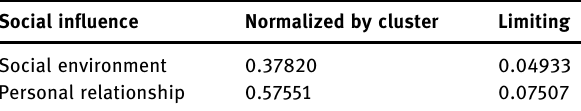
Table 6: Weight of social in fl uence sub - factor cluster